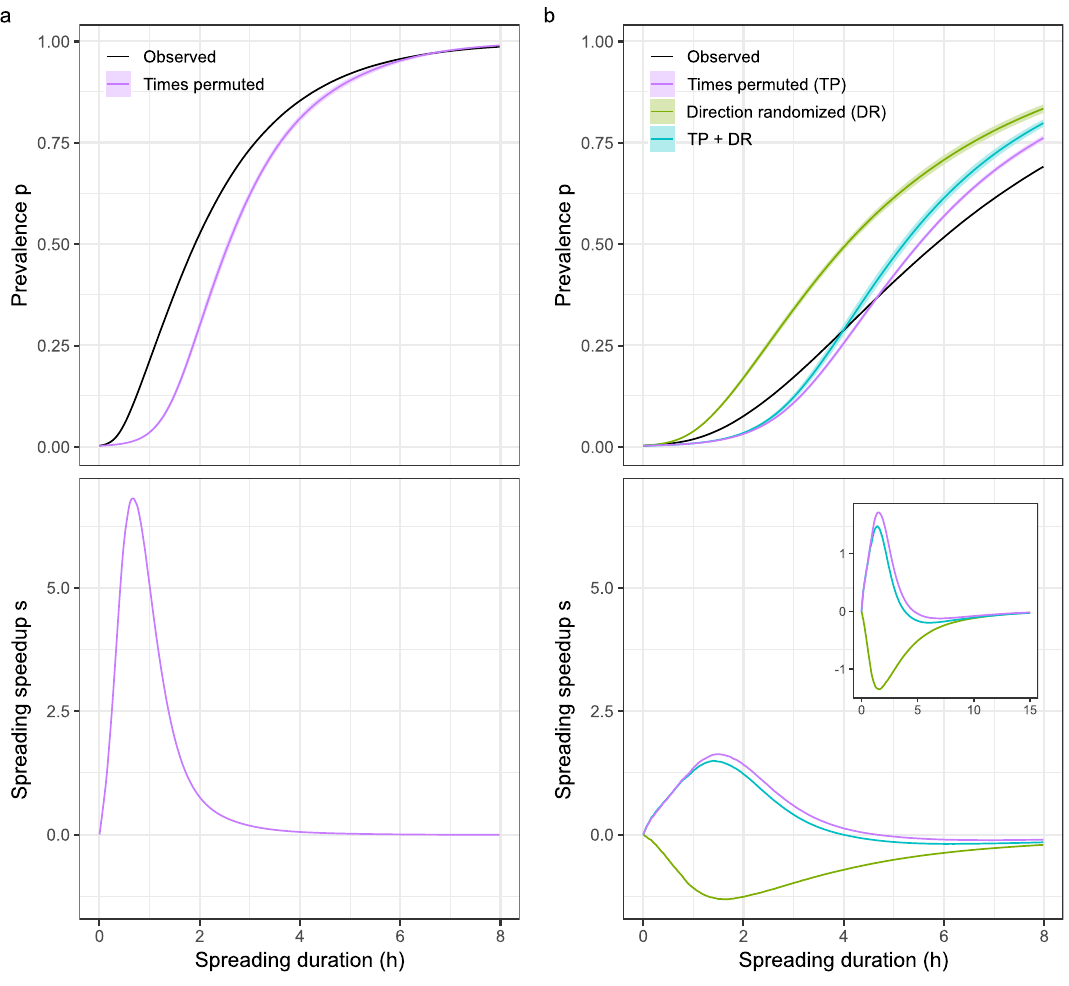
Figure 3. Simulated spreading though honey bee trophallaxis networks. Panels show data from Trial 1; see Supplementary Figs. 2, 3 for Trial 2 and 3, respectively, which yielded similar results. ( a ) Undirected spreading results, modeling transmission via physical contacts during trophallaxis. Top panel: Average fraction of “infected” bees (prevalence) as a function of spreading duration. Black line, prevalence in the observed trophallaxis network; magenta line, mean prevalence, averaged across 5 temporally randomized reference networks; magenta band, point-wise 95% confidence interval. Bottom panel: Spreading speedup, corresponding to the normalized difference between the prevalence in the observed network and the mean prevalence across the 5 temporally randomized reference networks, as a function of spreading duration. The spreading speedup is positive if the prevalence in the observed trophallaxis network is higher than in the randomized reference networks, zero if there is no difference, and negative if it is lower. Simulation results indicate that the temporal pattern of trophallaxis accelerates undirected spreading. ( b ) Directed spreading results, modeling liquid flow. Panels as in a . Green, prevalence and spreading speedup in directionally randomized reference networks; turquoise, prevalence and spreading speedup in temporally and directionally randomized reference networks. Simulation results indicate that the temporal pattern of trophallaxis accelerates directed spreading during the early phase of the spreading process, but inhibits it later. The directional nature of trophallaxis inhibits directed spreading throughout. Inset: Spreading speedup as a function of spreading duration until, like for undirected spreading, almost all bees are “infected”, showing that all three spreading speedups remain negative for longer spreading durations (corresponding prevalence curves in Supplementary Fig.